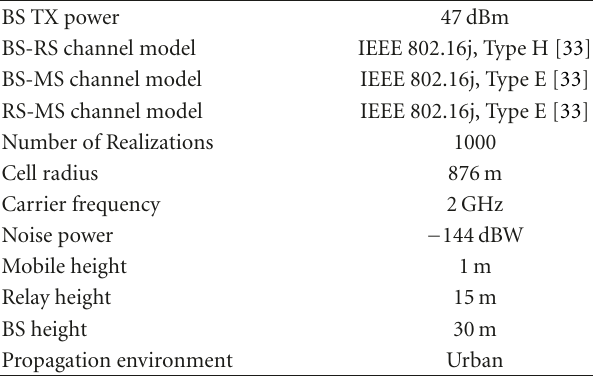
Table 3: System parameters used for the simulations in this